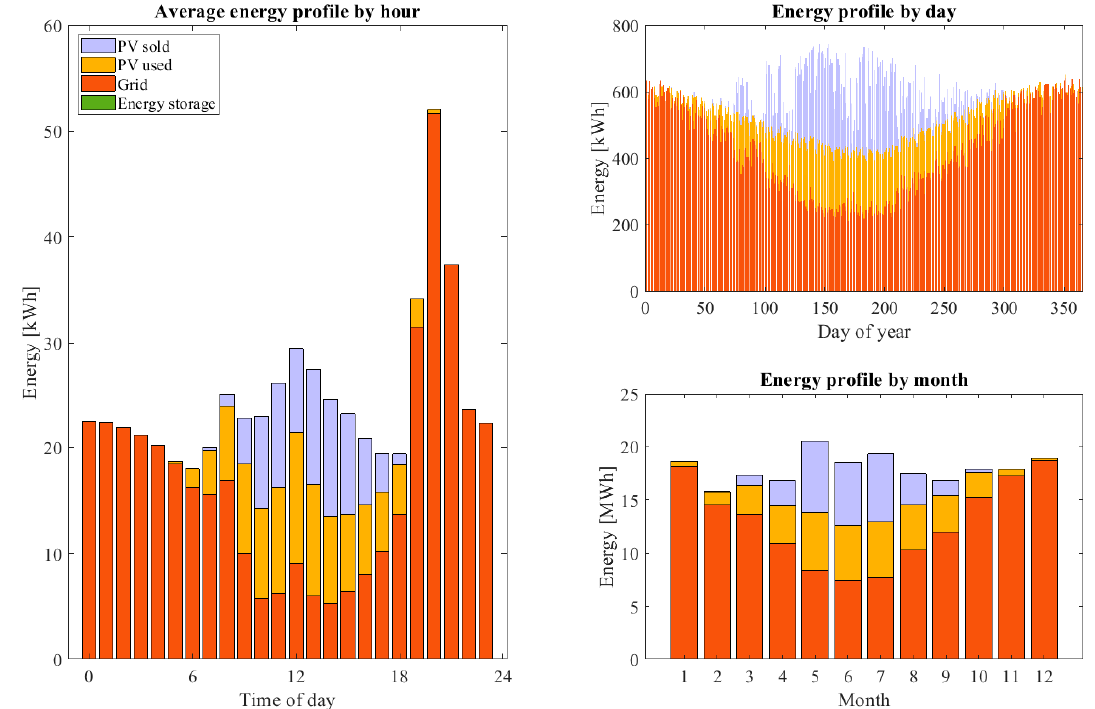
Figure 11. Average energy profiles by hour, and aggregated per day, and month in scenario 1.a.